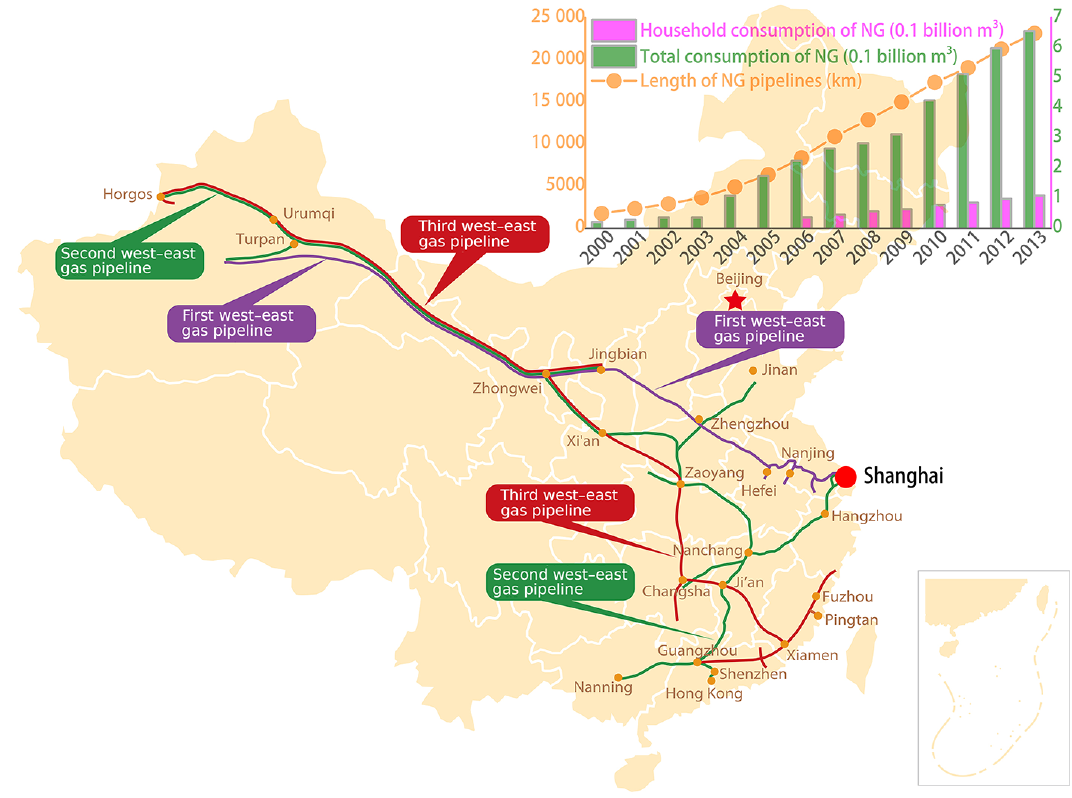
Figure 1. Every pipeline leads to Shanghai. The west–east pipeline project (WEPP) is a set of natural gas pipelines which transport clean natural gas from Xinjiang to the energy-hungry Yangtze River Delta region (including Shanghai). Started in 2002, the construction of the WEPP is one of China’s largest energy infrastructures. The first, second, and third pipelines were completed in 2005, 2011, and 2015, respectively. The figure at the top right shows the rapid increase of pipeline construction and natural gas consumption in Shanghai between 2000 and 2013 (data are available at